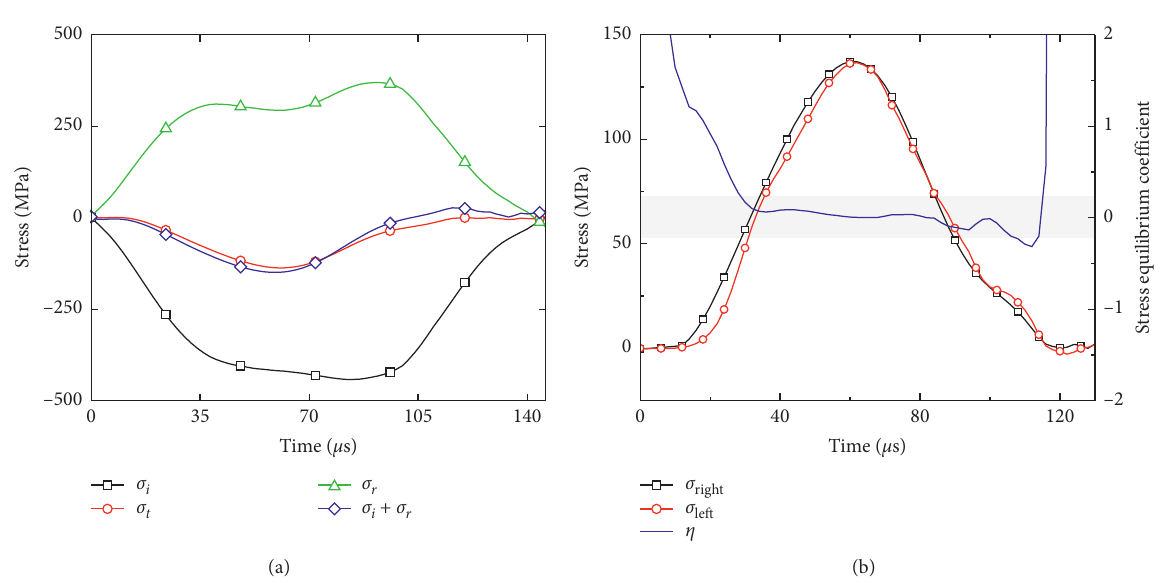
Figure 6: The dynamic stress equilibrium state of SHPB numerical model. (a) Three-wave method to check numerical stress equilibrium. (b) Direct measurement method to check stress